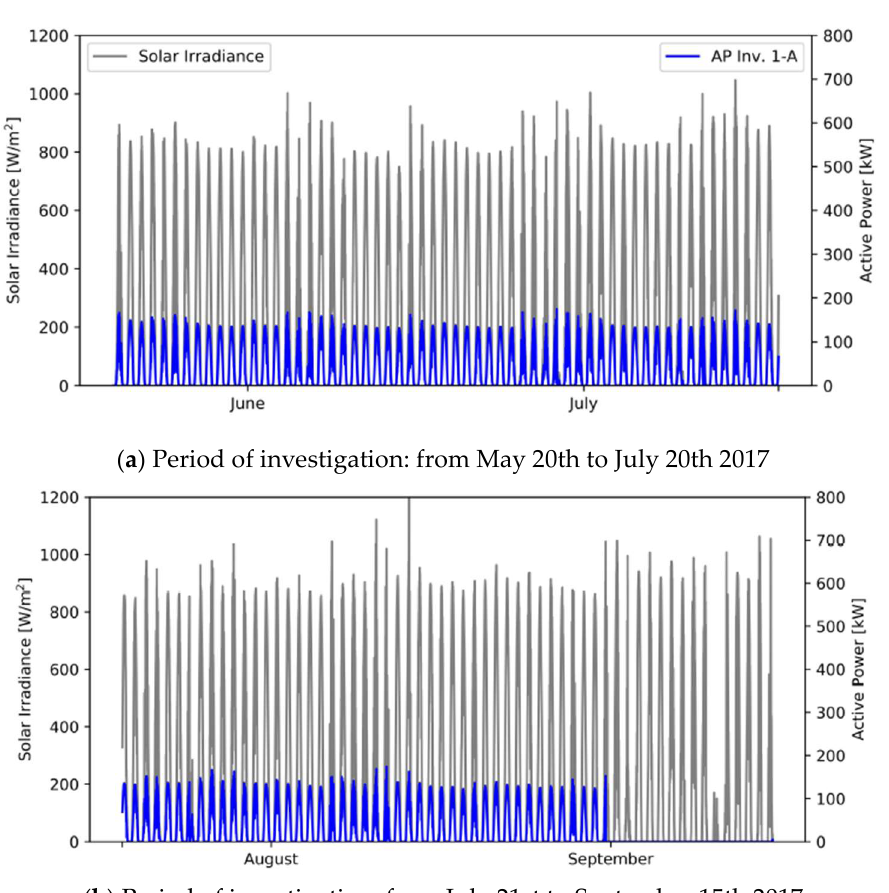
Figure 2. Solar irradiance and active power of the inverter 1 (block A) during the period of investigation.